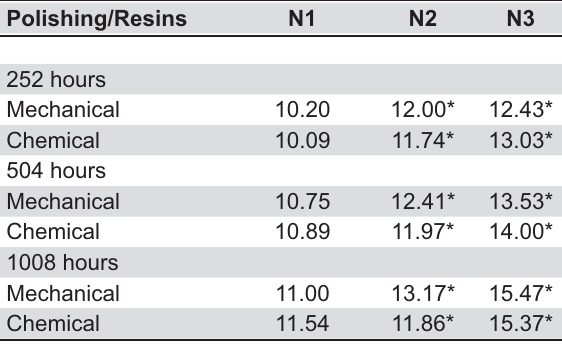
Table 1- (cid:2)(cid:3)(cid:4)(cid:5)(cid:6)(cid:2)(cid:7)(cid:5)(cid:8)(cid:9)(cid:4)(cid:10)(cid:2)(cid:11)(cid:12)(cid:2)(cid:13)(cid:11)(cid:8)(cid:11)(cid:14)(cid:2)(cid:15)(cid:4)(cid:14)(cid:16)(cid:7)(cid:5)(cid:17)(cid:16)(cid:7)(cid:4)(cid:10)(cid:2)(cid:18)(cid:19)(cid:20)(cid:21)(cid:2)(cid:11)(cid:12)(cid:2)(cid:14)(cid:4)(cid:10)(cid:16)(cid:6)(cid:10)(cid:2) regarding polishing methods